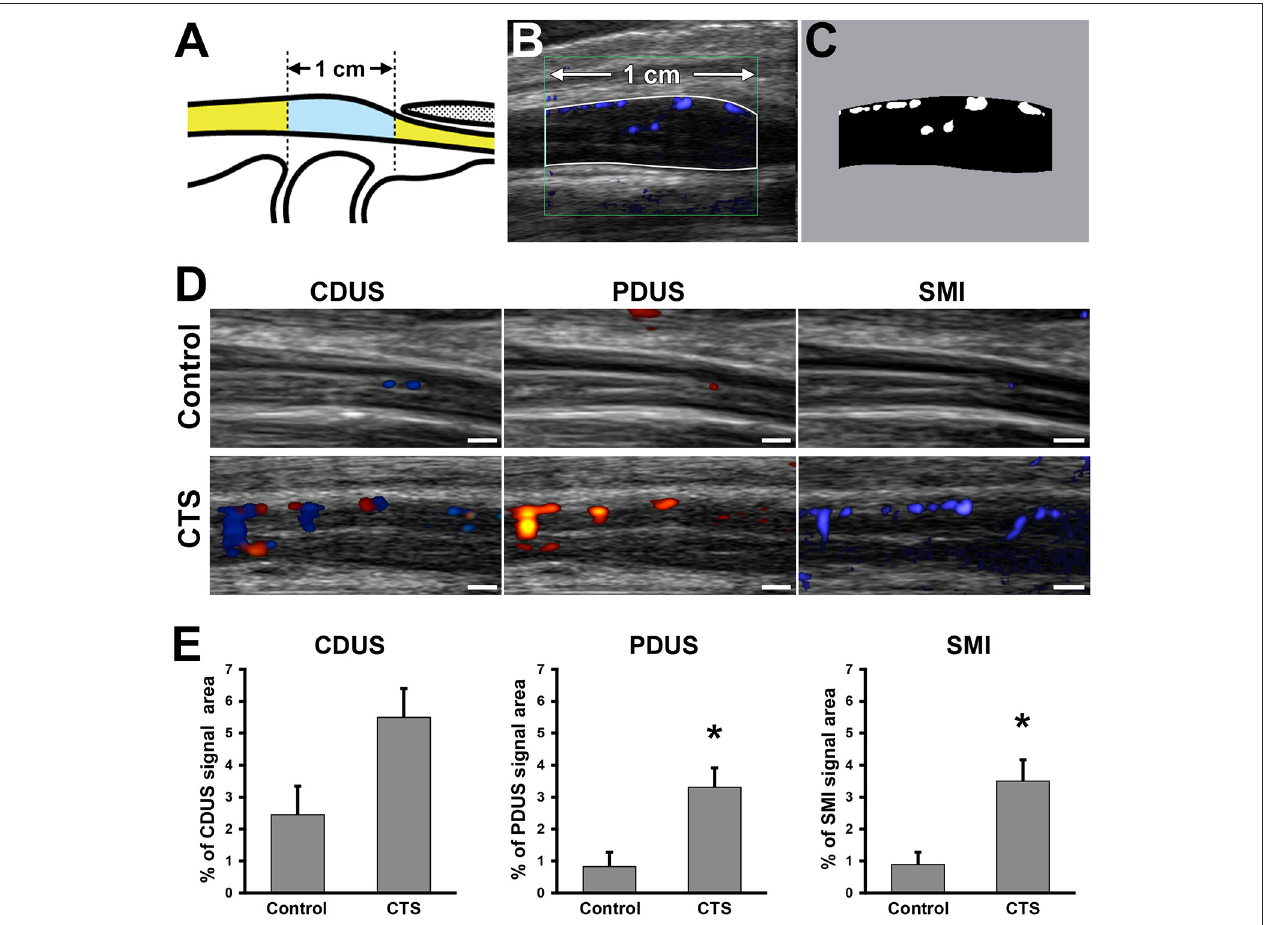
FIGURE 3 | Blood flow signal analysis of the median nerve around the carpal tunnel. Illustration indicates the observed area on ultrasound examination (A) . Representative ultrasonography image (B) . White line indicates the 1-cm wide analyzed region. (C) Bifurcated image of the analyzed region in (B) . White pixels indicate the blood flow signal area. Black pixels indicate other areas. Ultrasonography of the median nerve using color Doppler ultrasound (CDUS), power Doppler US (PDUS), and superb microvascular imaging (SMI) (D) . Scale bars: 1mm. Quantification of the blood flow signal area with each technique (E) . * P < 0.05, Student’s t -test. Data are presented as mean ± standard error of the